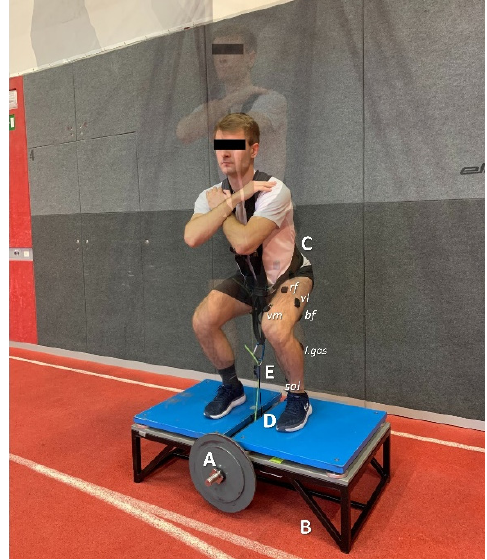
Figure 1. The inertia of a spinning flywheel (FW) ( A ) produced resistance during squat performance. Subjects stood on a platform ( B ) (size 1.1 × 0.6 m), with the pulling rope (with a diameter of 0.006 m) wrapped around the rotating shaft, 0.03 m in diameter. The resistance from the FW device was transmitted to the body by means of a harness ( C ). The wire of a draw-wire sensor was placed directly above the axis center so to avoid distorting its position due to diagonal vertical displacement ( D ). The distal draw-wire attachment was in the same location as the harness pulling the rope at- tachment (which was between the legs) ( E ).